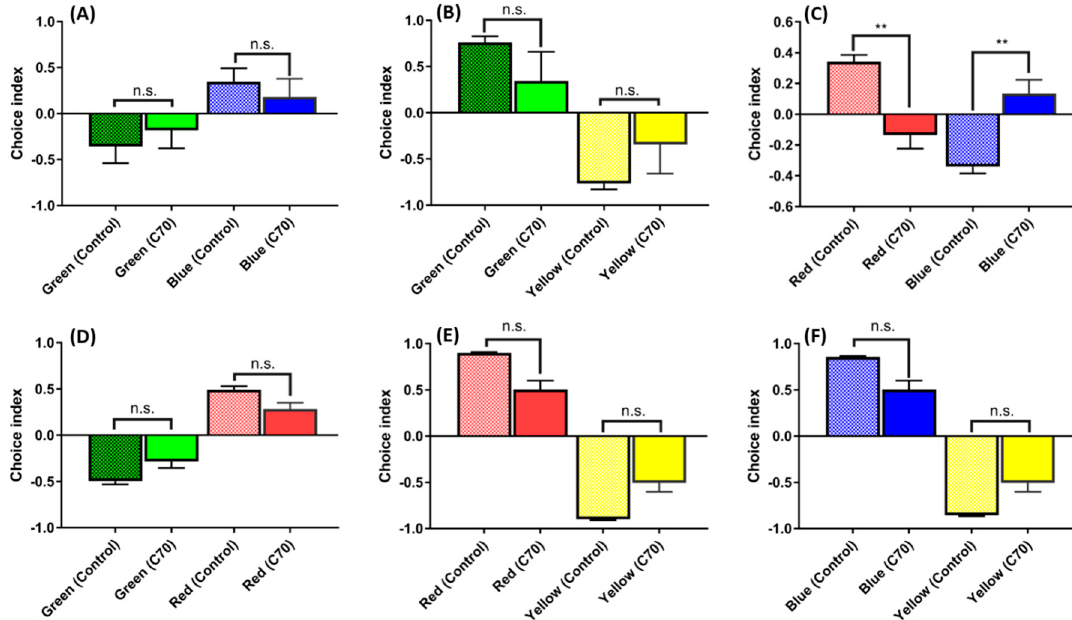
Figure 5. Comparison of color preferences between the untreated control and 1.5 ppm of C 70 NP-exposed fish: ( A ) green vs. blue combination; ( B ) green vs. yellow combination; ( C ) red vs. blue combination; ( D ) green vs. red combination; ( E ) red vs. yellow combination; and ( F ) blue vs. yellow combination. Since all of the data were not normally distributed, they were analyzed using non-parametric Kruskal–Wallis followed by Dunn’s post-hoc test, and p < 0.05 was considered significantly different. The data are presented with mean ± SEM with n = 24, n.s. = not significant, ** p < 0.01.